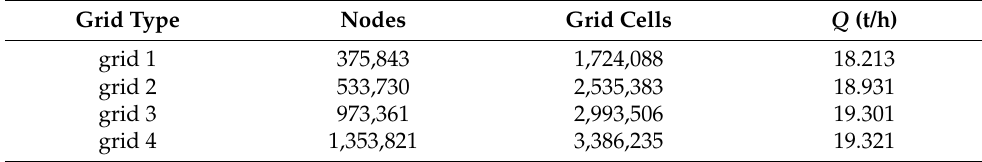
Table 1. Independence test of flow channel grid.